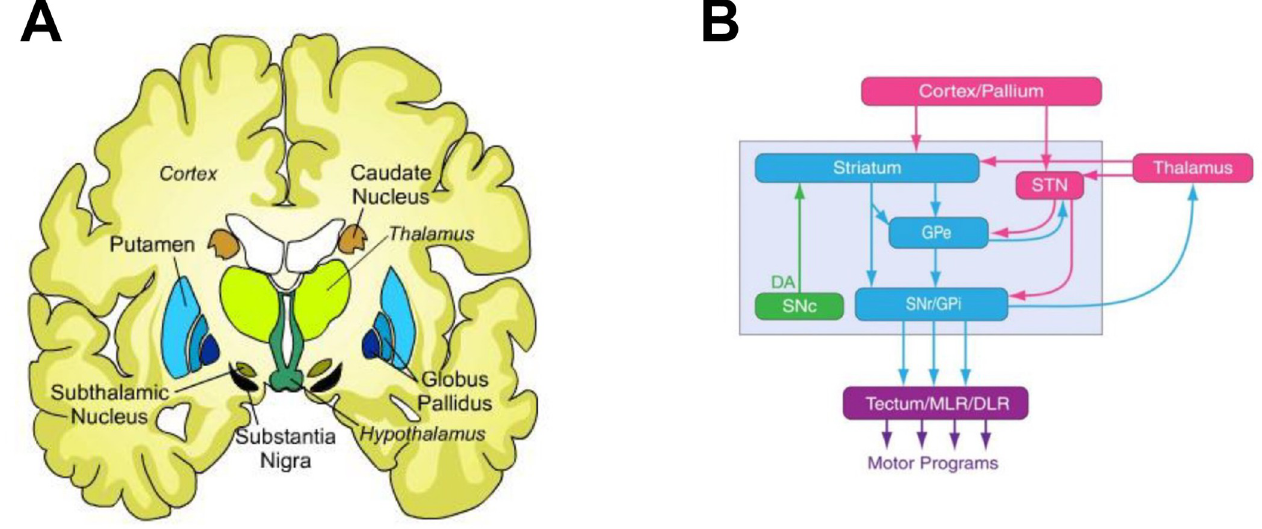
Fig 9. Simple scheme of basal ganglia connectivity. A) Location of the basal ganglia in an axial cartoon view of the brain. B) Basal ganglia connectivity. Arrows indicate direction of connectivity. Glutamatergic (Glu) structures are shown in rose, GABAergic nuclei are shown in cyan, and the dopaminergic (DA) nucleus is shown in green. STN, subthalamic nucleus; SNC, substantia nigra pars compacta; GPe, global pallidus external; GPi, global pallidus internal; SNr, Substantia nigra; MLR, midbrain locomotor region; diencephalon locomotor region.